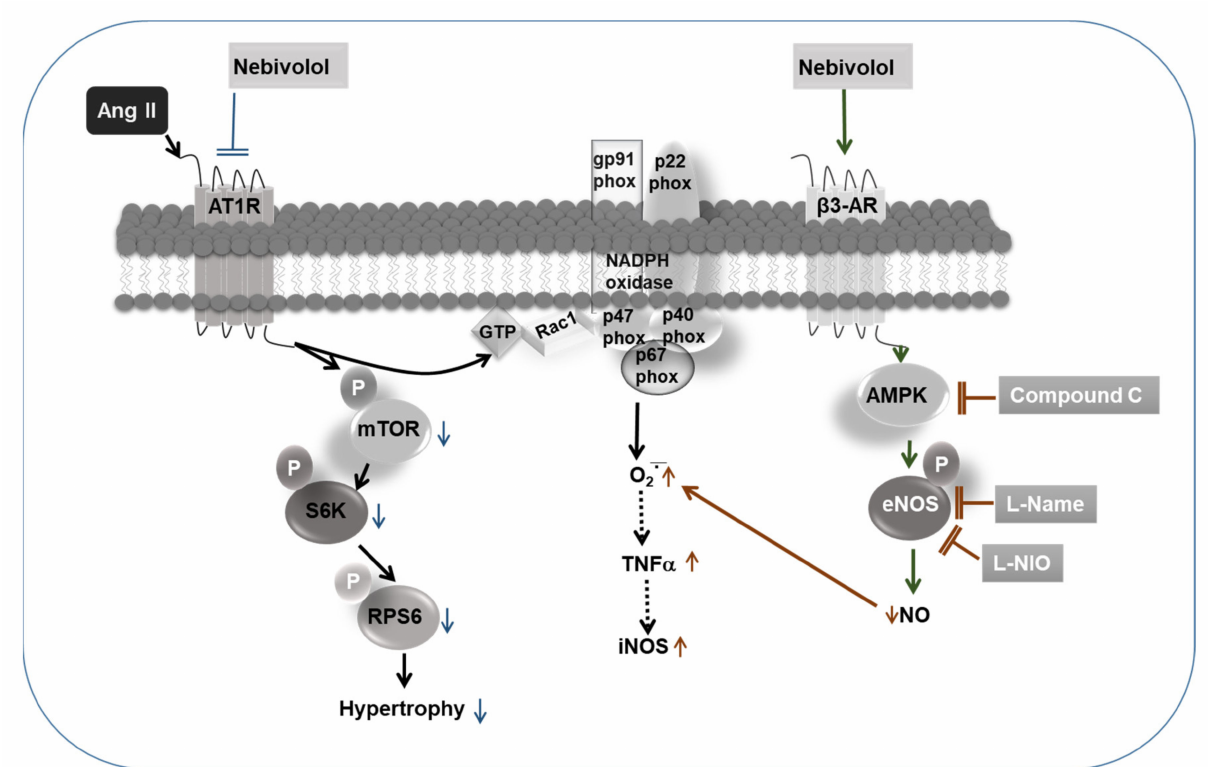
Figure 6. Schematic diagram showing that the protective effects of nebivolol on Ang II-induced signaling are partially blunted by inhibition of eNOS and AMPK. NO production via the agonistic activation of β 3-AR/AMPK/eNOS pathway by nebivolol is required for its inhibitory effects on Ang II-induced ROS generation and activation of proinflammatory cytokines, such as TNF- α and iNOS. On the contrary, inhibitory effects of nebivolol on Ang II-mediated mTORC1 signaling and hypertrophic response are completely independent of NO